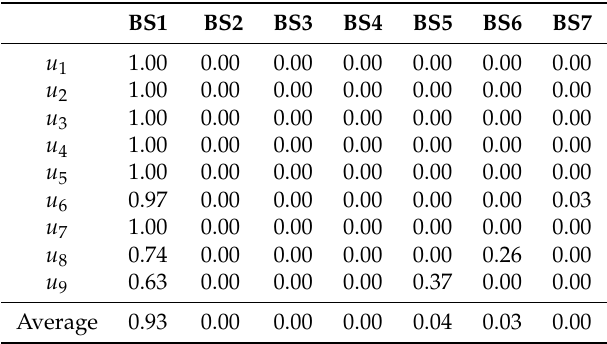
Table 3. Equilibrium for cluster heads in BS1 when p = 10 − 13.5